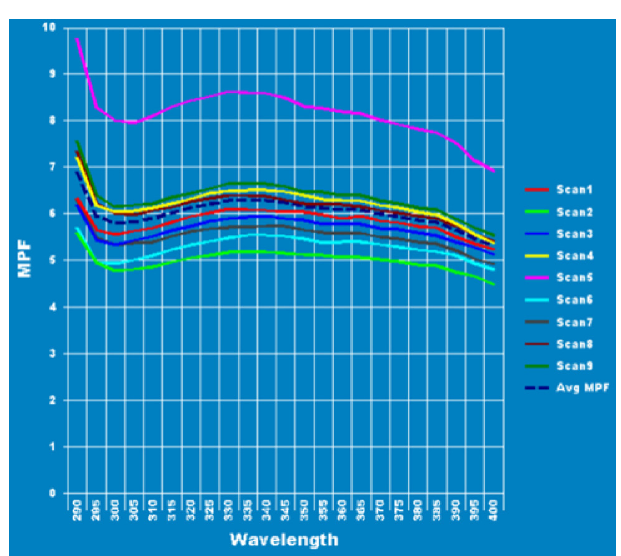
FIGURE 2 - An example of absorbance pattern during in vitro SPF